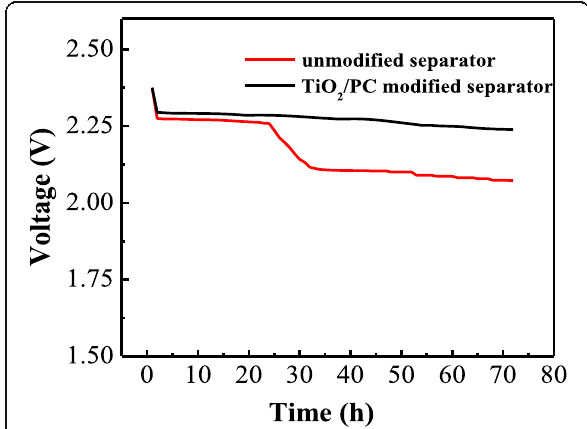
Fig. 12 Open-circuit voltage profiles of the cells with unmodified and TiO 2 /PC-modified separator during 72 h rest